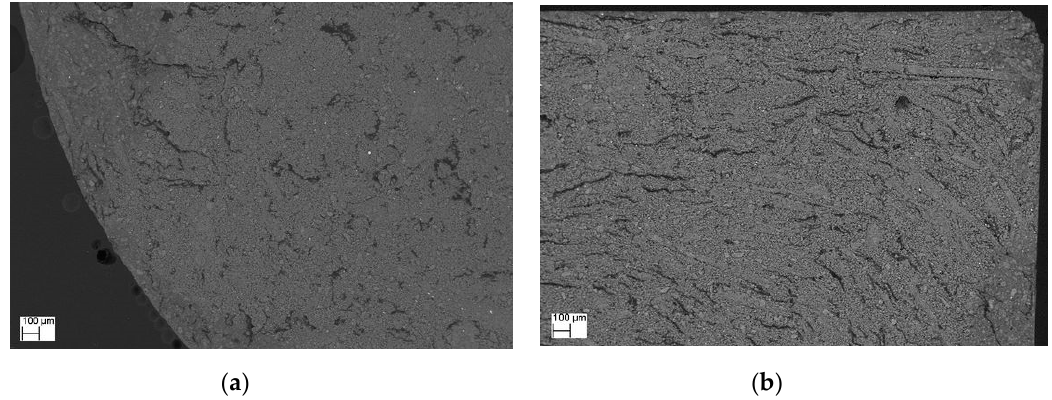
Figure 5. SEM images obtained by direct observation of the MgH 2 –5Fe–5ENG pellets after 20 ( a , b ) and 45 cycles ( c , d ) at different magnifications.